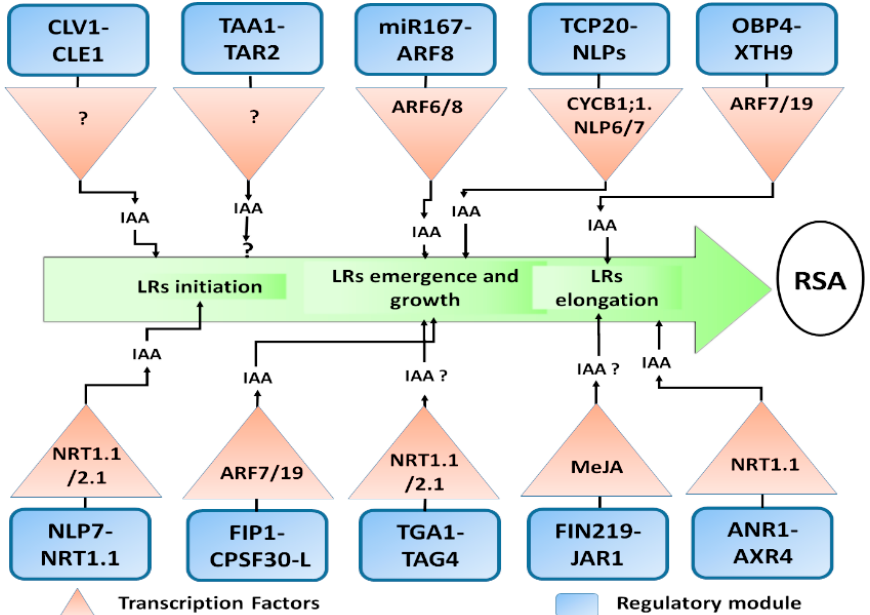
Figure 4. Molecular players involved in nitrate signalling regulating the primary and lateral roots; Schematic presentation of a regulatory module involved in the nitrate-mediated auxin response in Arabidopsis root. For clarity purposes, all players and their secondary transcription factors (both upstream and downstream) are presented with blue and black colors respectively, which might not be the case in a plant cell. Auxin fluxes and accumulations contribute to primary and lateral root growth are indicated with the black arrow. However, the detailed mechanism and other transcripts are still